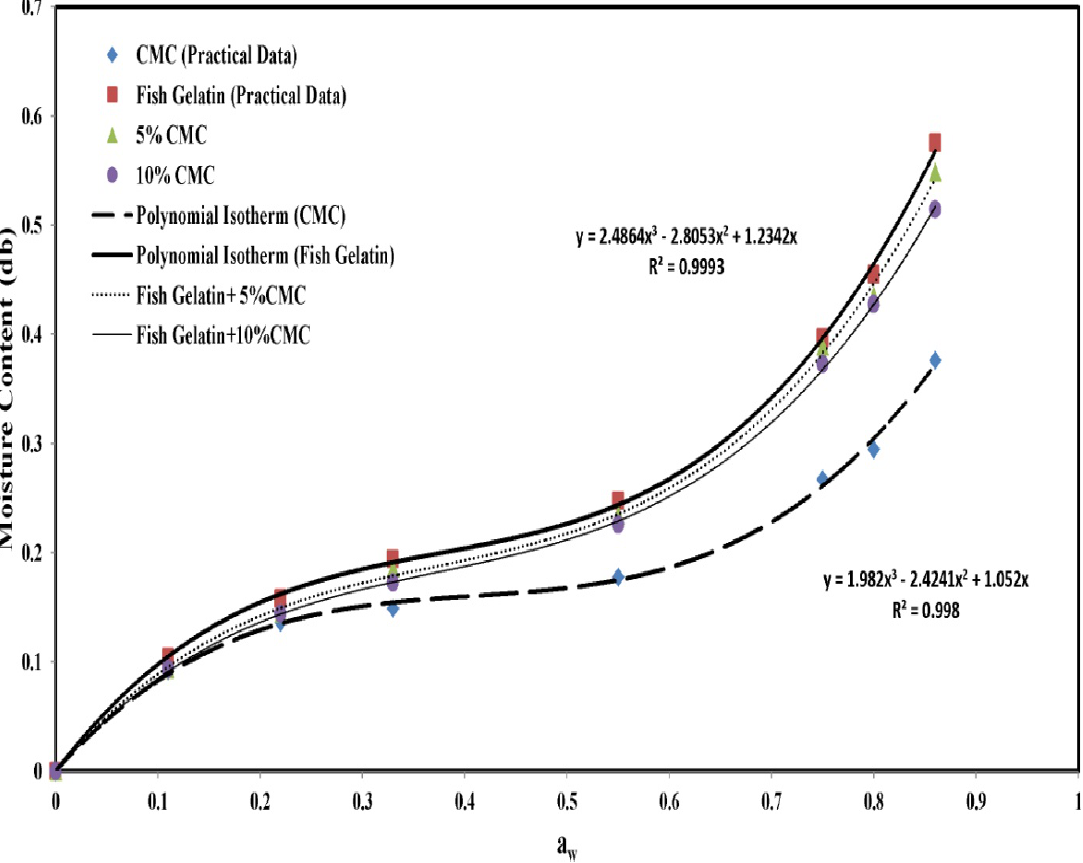
Figure 2. Moisture absorption of gelatin films as a function of CMC content.